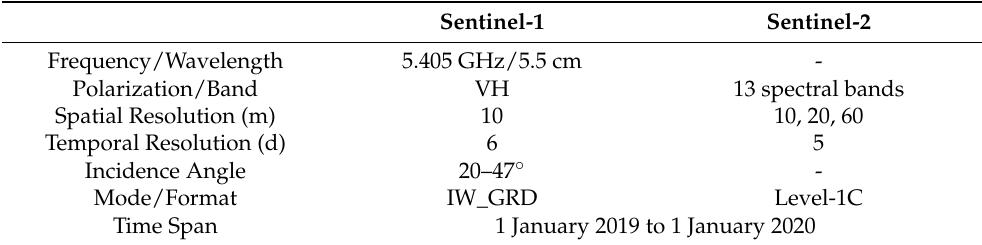
Table 1. Sentinel-1/2 data